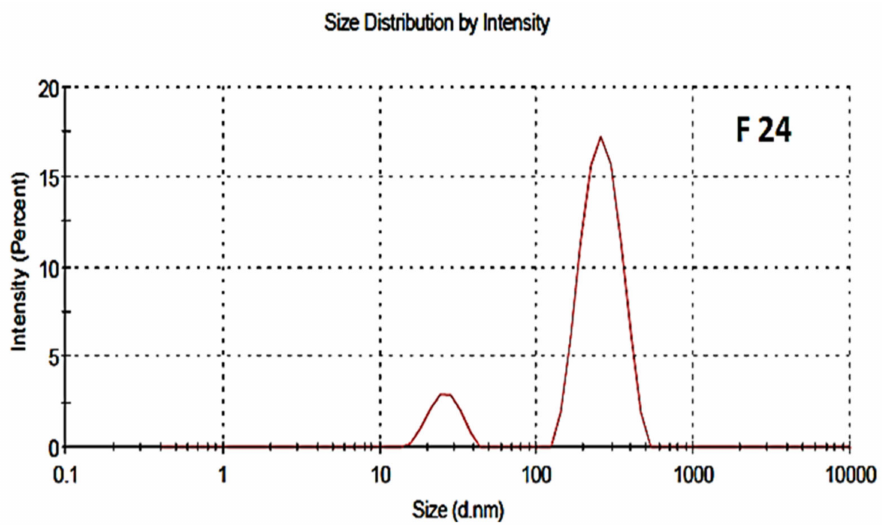
Figure 4. Particle size distribution of blank NPs,